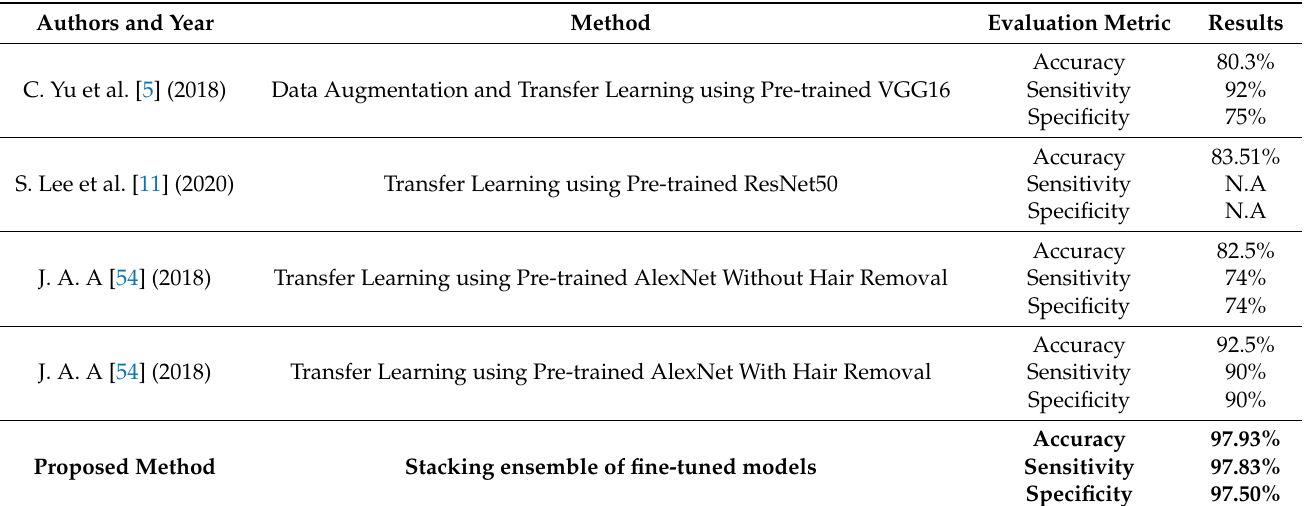
Table 7. Comparison of stacked ensemble model with existing